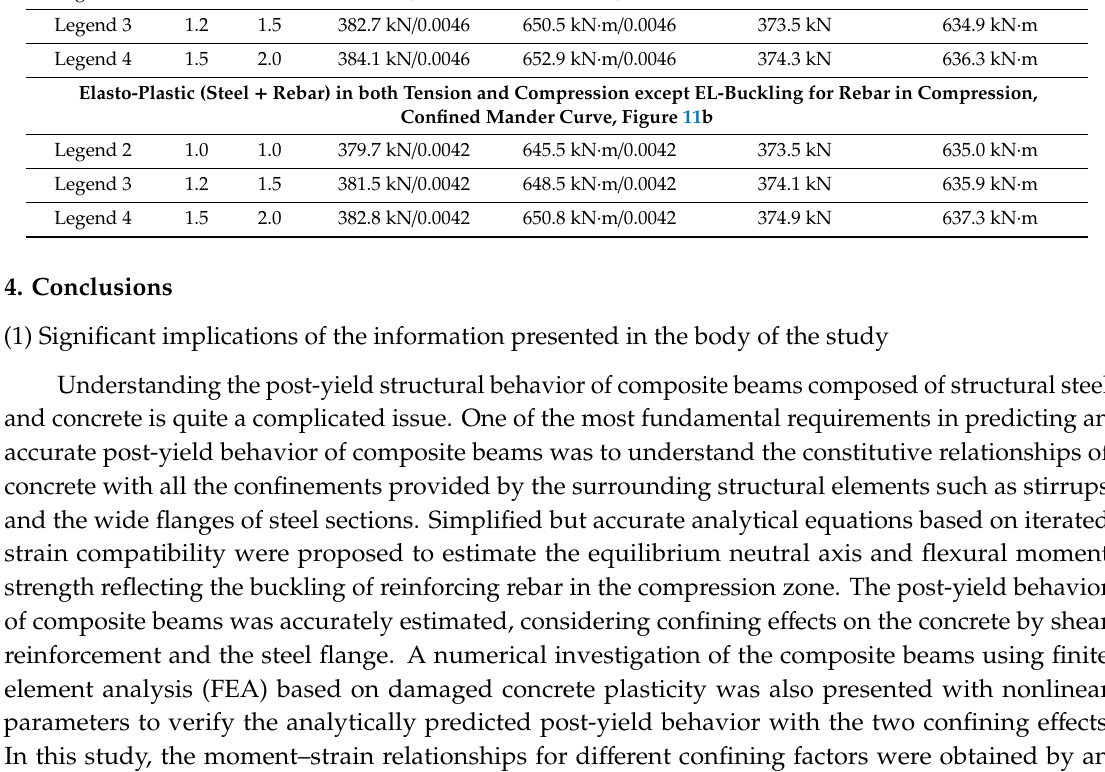
Table 1. Flexural capacities at the maximum load and design load limit states. Maximum Maximum Moment / Concrete K p K h Load / Concrete Strain Strain = 0.003) =